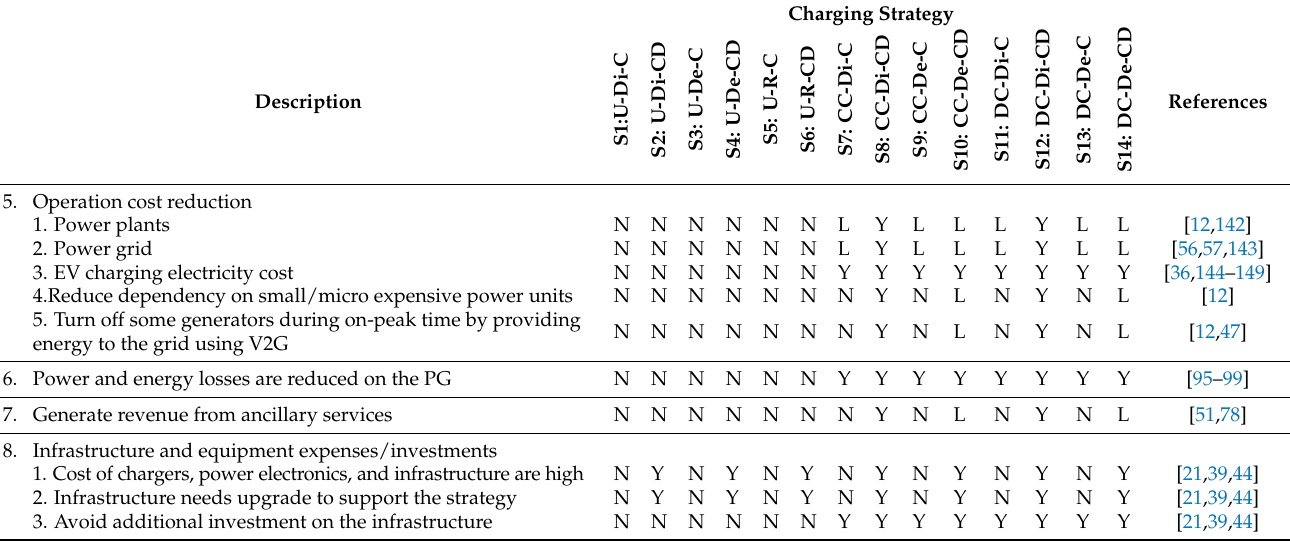
Table 5. Economic and Power Losses Comparison for Different EV Charging Strategies.